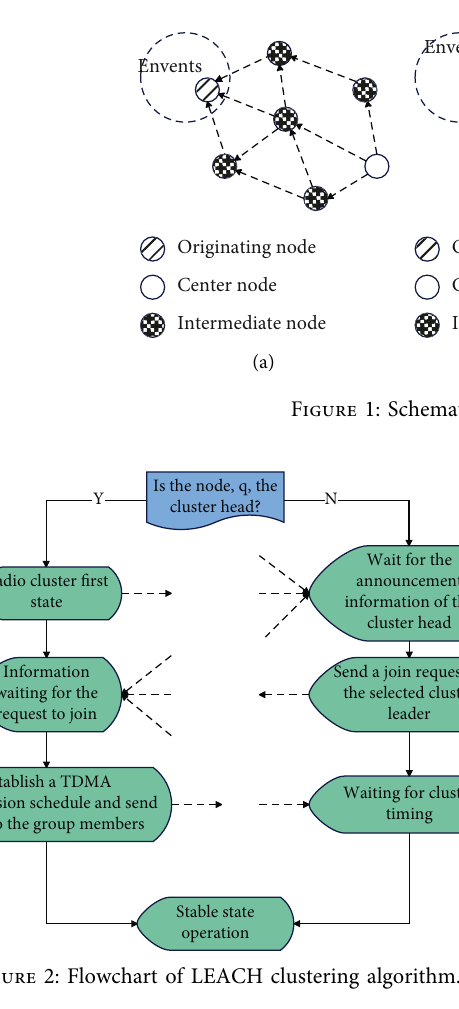
Figure 3: Three-dimensional cell space model